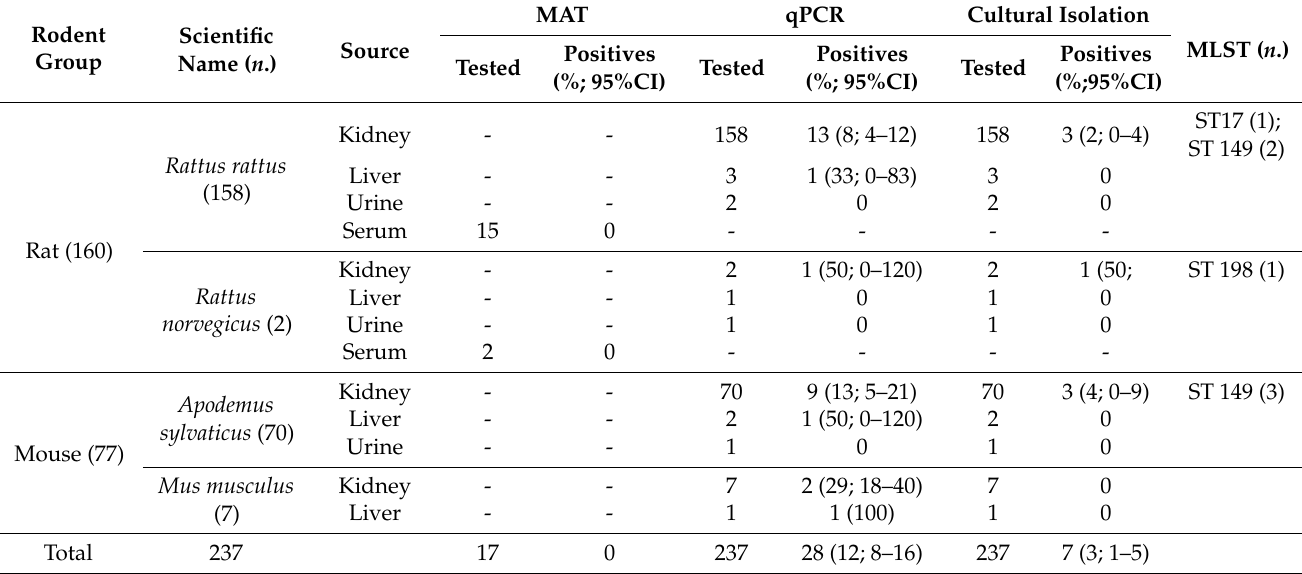
Table 6. Results of serology by MAT, qPCR, culture assay, and MLST performed on samples collected from rodents. Rodent Group